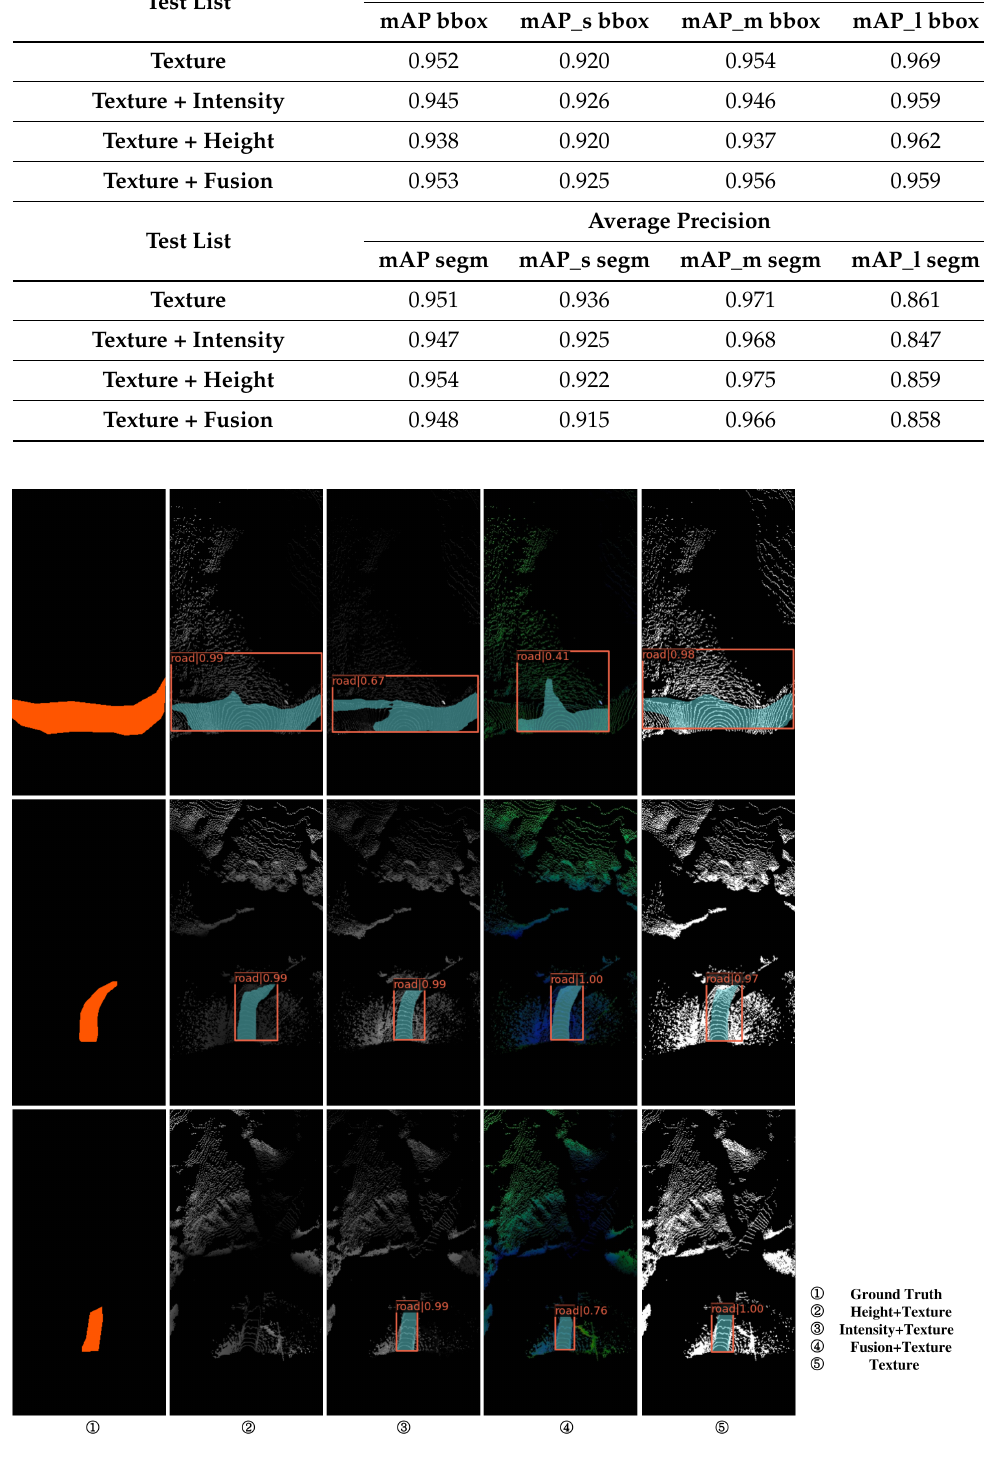
Figure 6. Display of validation set test